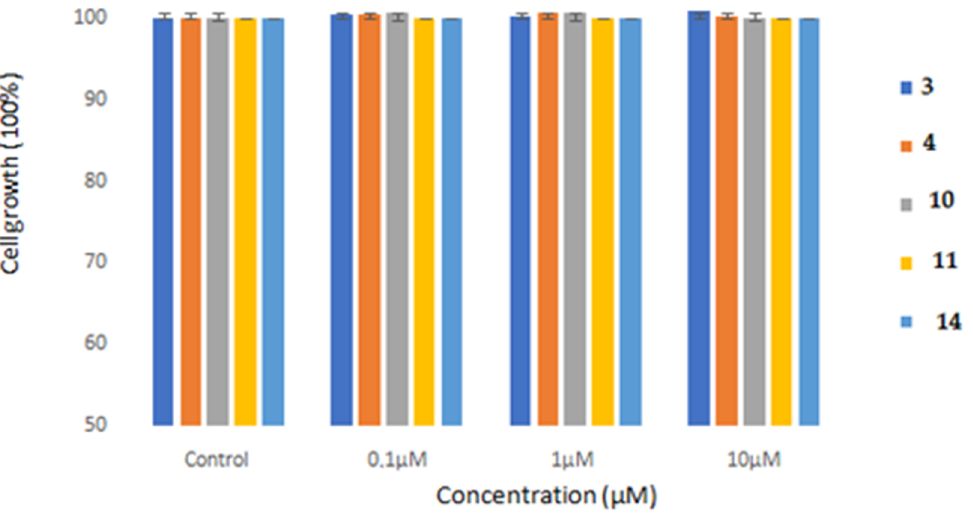
Figure 7. Cell proliferation assessment of MRC-5 cell lines subjected to different derivatives in cell culture. MRC-5 cell lines grown in culture were incubated separately with each of the derivatives at concentrations of 0.1, 1 and 10 μM for 48 h. The cell number was analyzed in cell cultures with microscopic techniques (Neubauer counting chamber), as reported in “Methods” and expressed as % of the proliferation of cultures involving control untreated cells. The studies displayed above show the mean numbers ± SD of two independent biological tests ( n ≥ 3). The diagram illustrated above and the t -test statistical analysis were performed utilizing the GraphPad Prism 6.0 program. No significant statistical difference between the control untreated culture cells with each tested derivative was